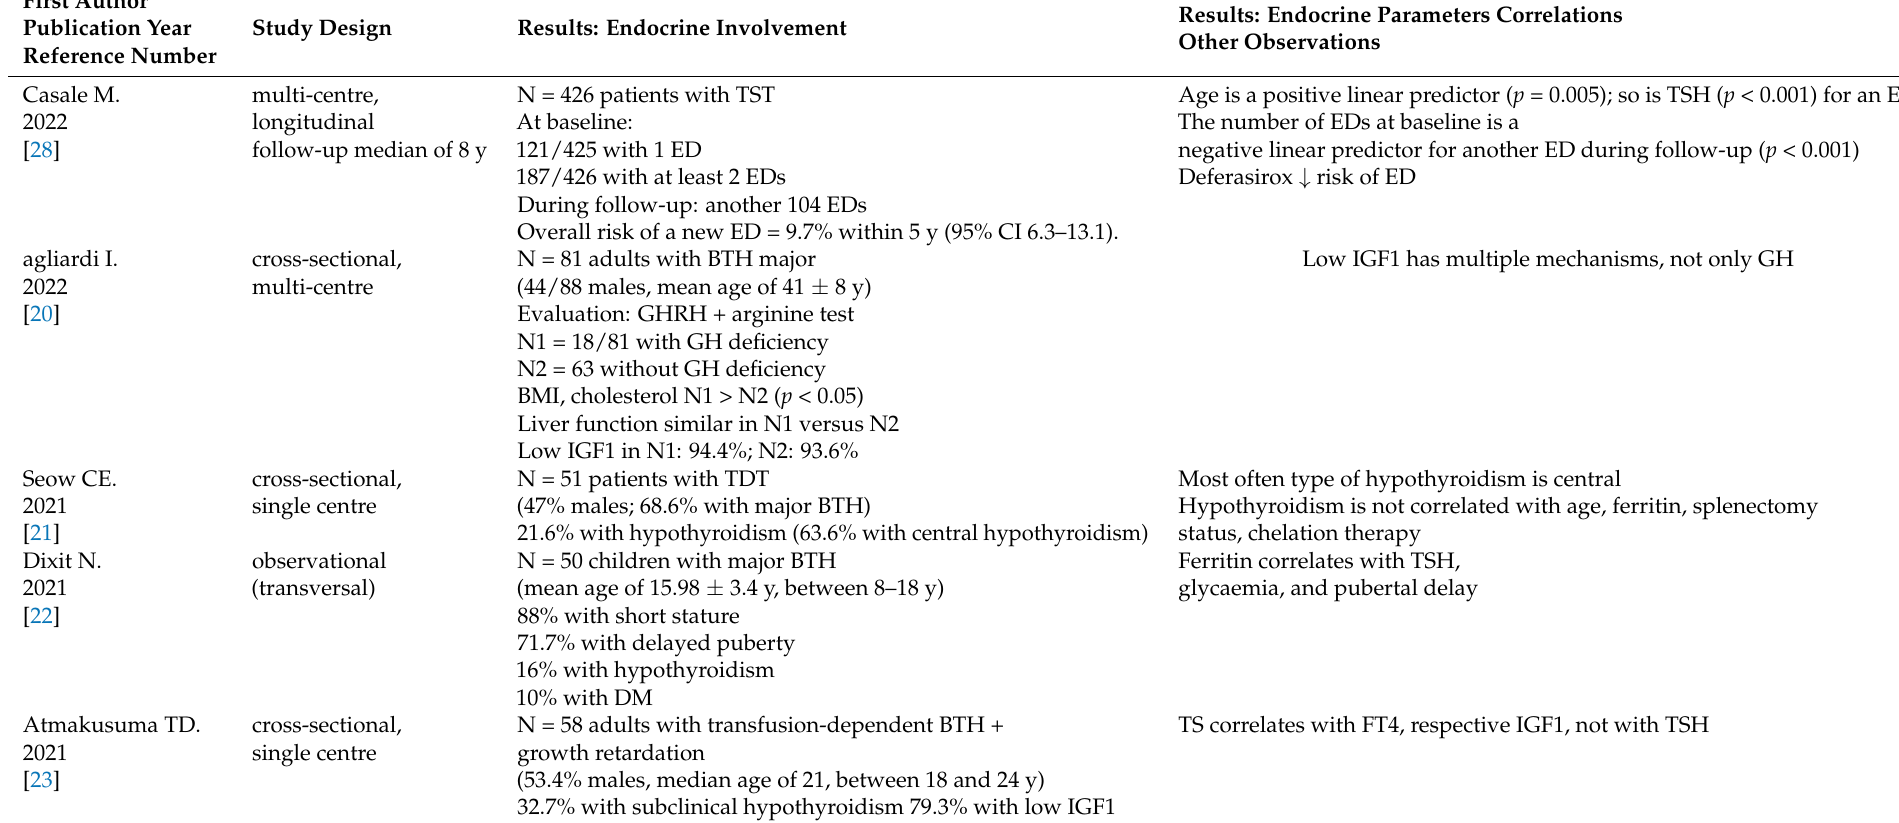
Table 1. Core endocrine descriptive analysis of thalassemic endocrine disease. (We selected studies with more than 40 patients, published between 2022 and 2017, with data concerning the ratio/prevalence of endocrine disorders among patients with major beta-thalassemia and potential correlations of endocrine involvement with specific parameters of underling disease or general health. The display is based on publication’ year starting with the most recent